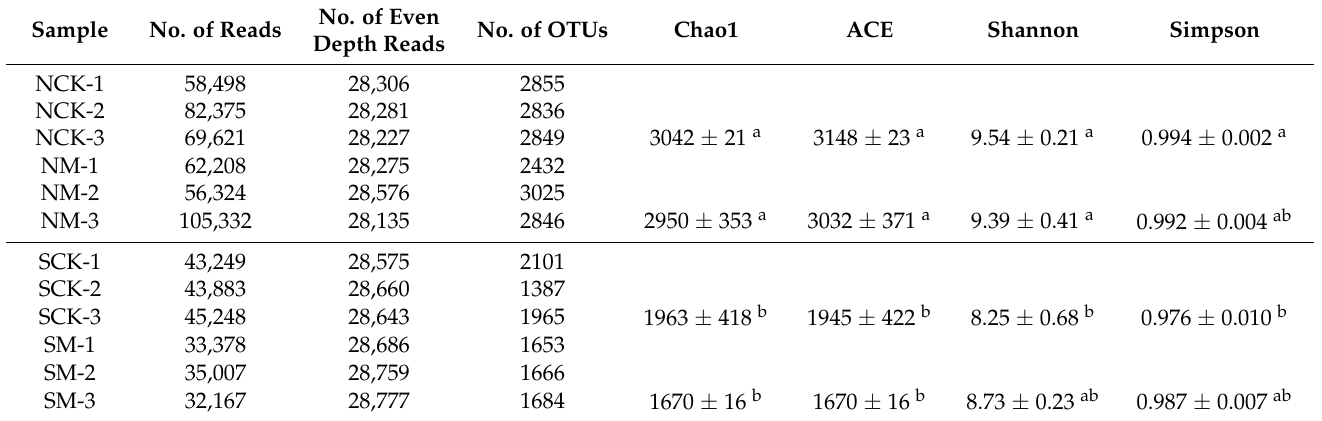
Table 2. α -diversity indices of ureC gene for the studied soil samples.